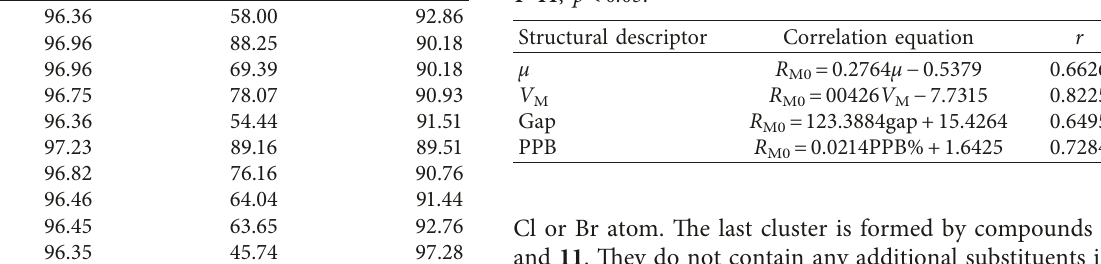
M0 and lipophilicity values theoretically calculated for compounds 1 – 11 , Correlation equation